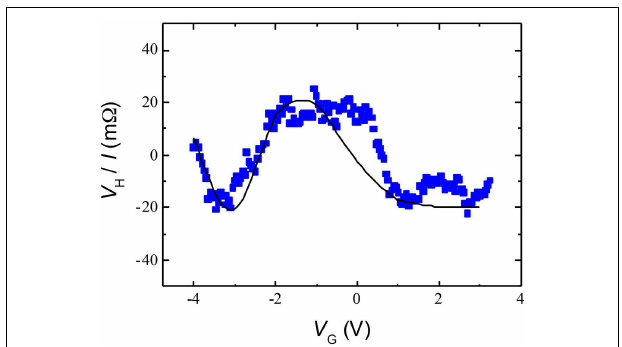
FIGURE 12 | Datta Das conductance oscillation for FM injection and ISHE detection. Symbols: data. Solid line: fit. Details of the fit are found in Koo et al. [22] and Zainuddin et al. [33]. w C I 0 . 1 mA. Baseline resistance is R B = et al.